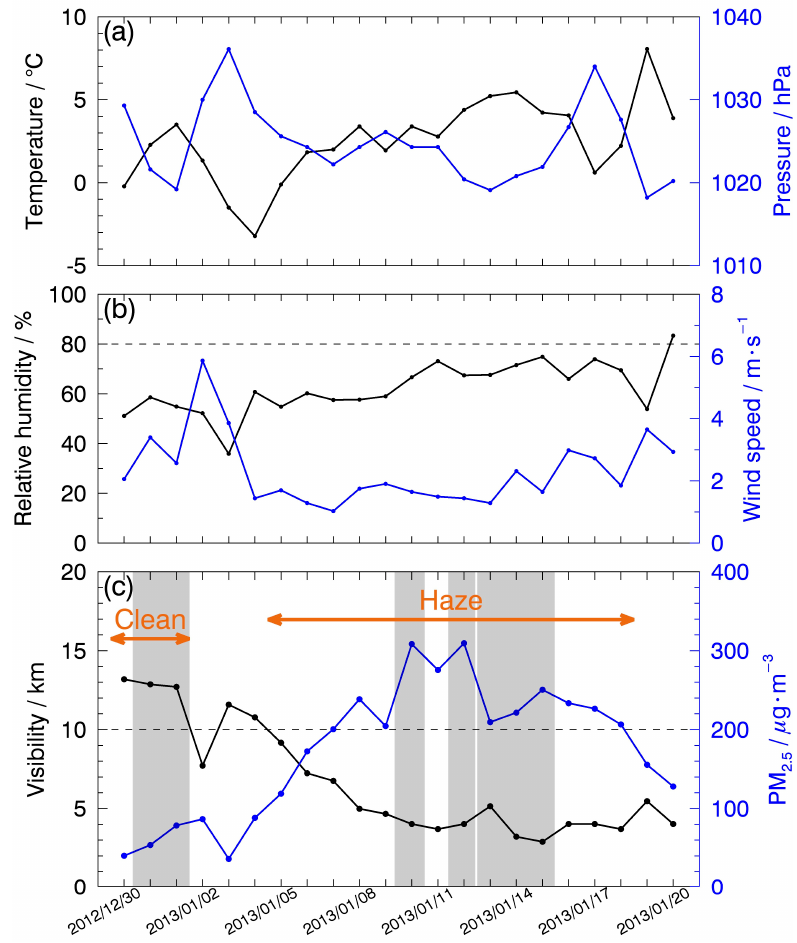
Figure 3. Daily average of surface ( a ) temperature and pressure, ( b ) relative humidity and wind speed, and ( c ) visibility and PM 2.5 mass concentration from 30 December 2012 to 20 January 2013 in Wuhan. The horizontal dashed lines in panel ( b , c ) indicate relative humidity and visibility, which are equal to 80% and 10 km, respectively. The clear and haze period are marked in panel ( c ) for further discussions. The shades in panel ( c ) indicate the intervals when lidar observations are available.